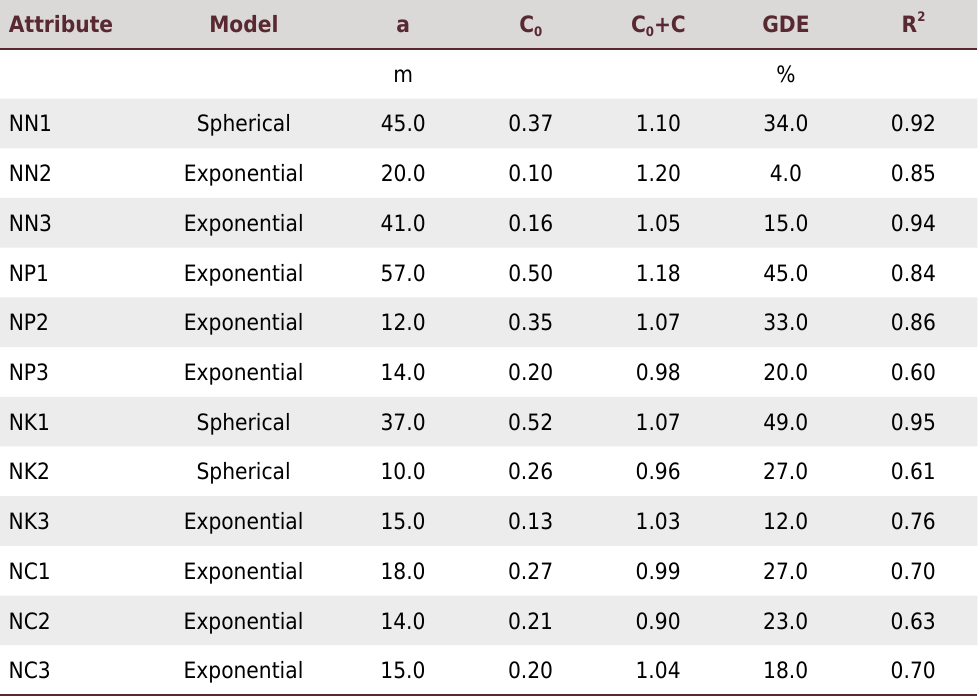
Table 4. Estimated models and parameters of the variograms scaled to the input application needs for the three coffee conilon crops